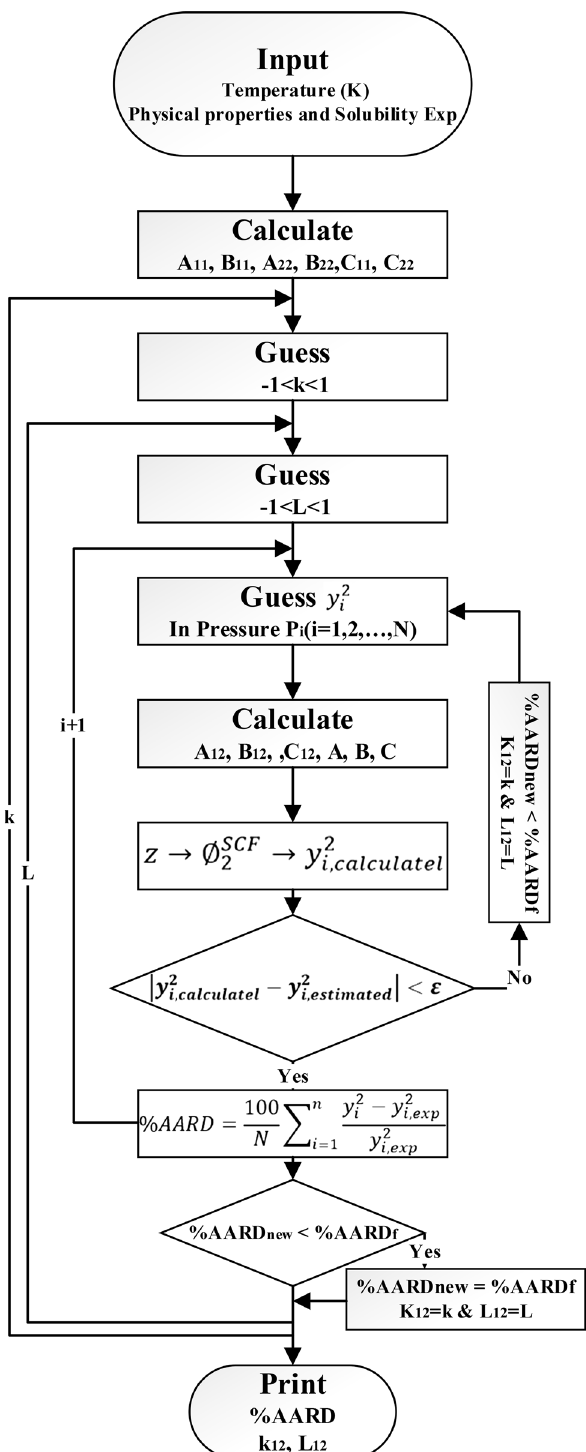
Figure 2. In the flowchart below, show the schematic of the